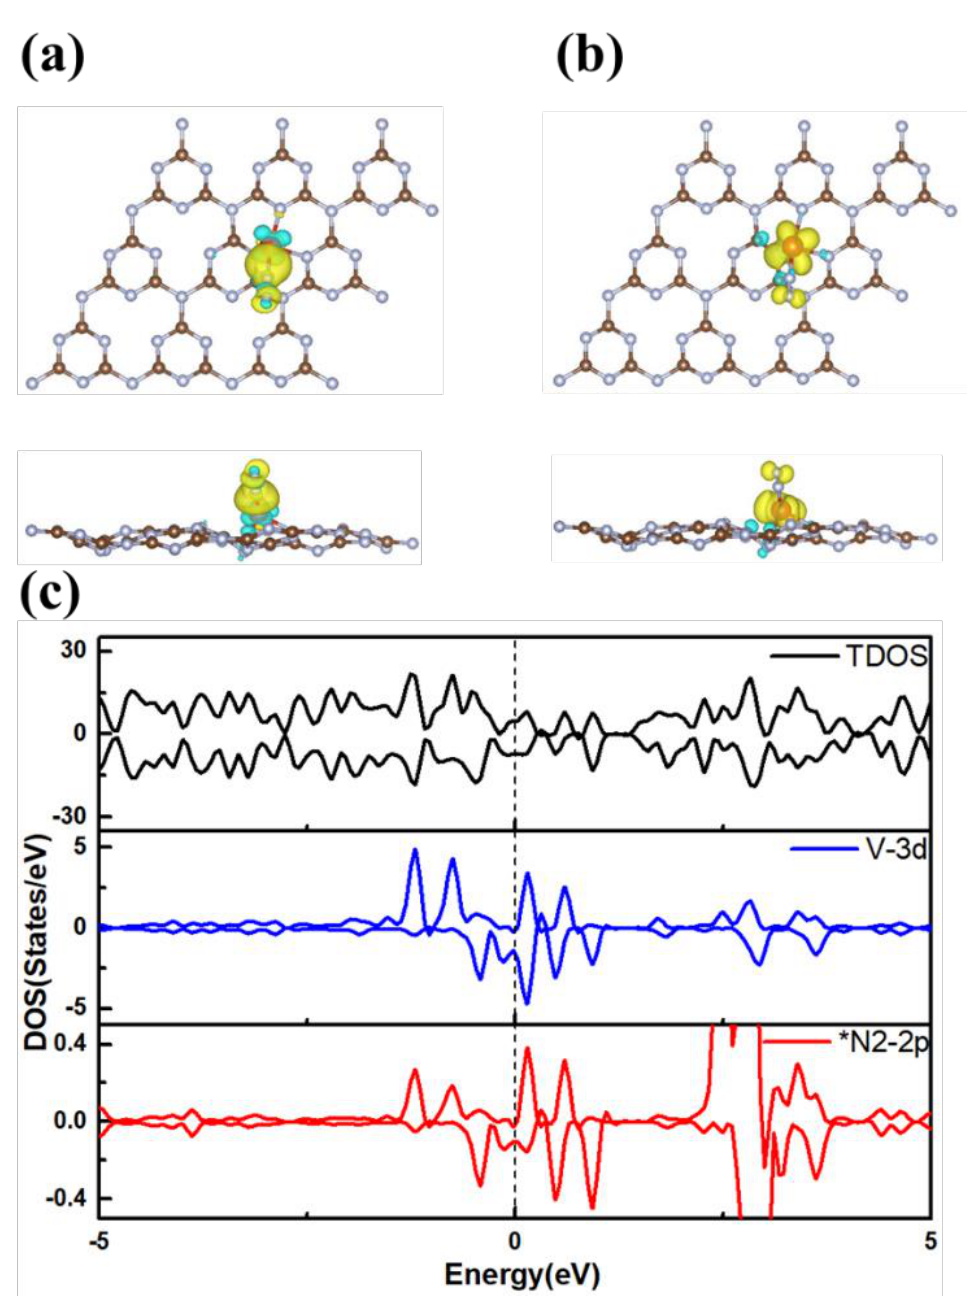
Figure 6. ( a ) Charge density difference with isosurface 0.004 e/Bohr 3 , the yellow and blue areas represent the accumulation and depletion of electrons, ( b ) spin density, the yellow and blue regions represent the spin-up and spin-down states, ( c ) DOS of N 2 /V@g-C 3 N 4 , the Fermi level is set to 0 eV. To further explore the charge transferred among intermediate adsorbent, the varia- tions of the charge transferred between them are studied. Based on the previous stud- ies [54,55], N x H y /V@g-C 3 N 4 is divided into three parts (Figure S5): g-C 3 N 4 substrate without V and the three N atoms bonded with it (moiety 1), V-3N (moiety 2), and the adsorbed intermediate N x H y (moiety 3). The charge variations along distal and alternating moiety between the present step and the previous step). For N 2 adsorption on V@g-C 3 N 4 monolayer in Figure 7a, V-3N offers 0.42 e and 0.45 e to *N 2 and g-C 3 N 4 , respectively. Dur- ing the protonation process ∗ N 2 + H + + e − = ∗ NNH , V-3N and g-C 3 N 4 substrate